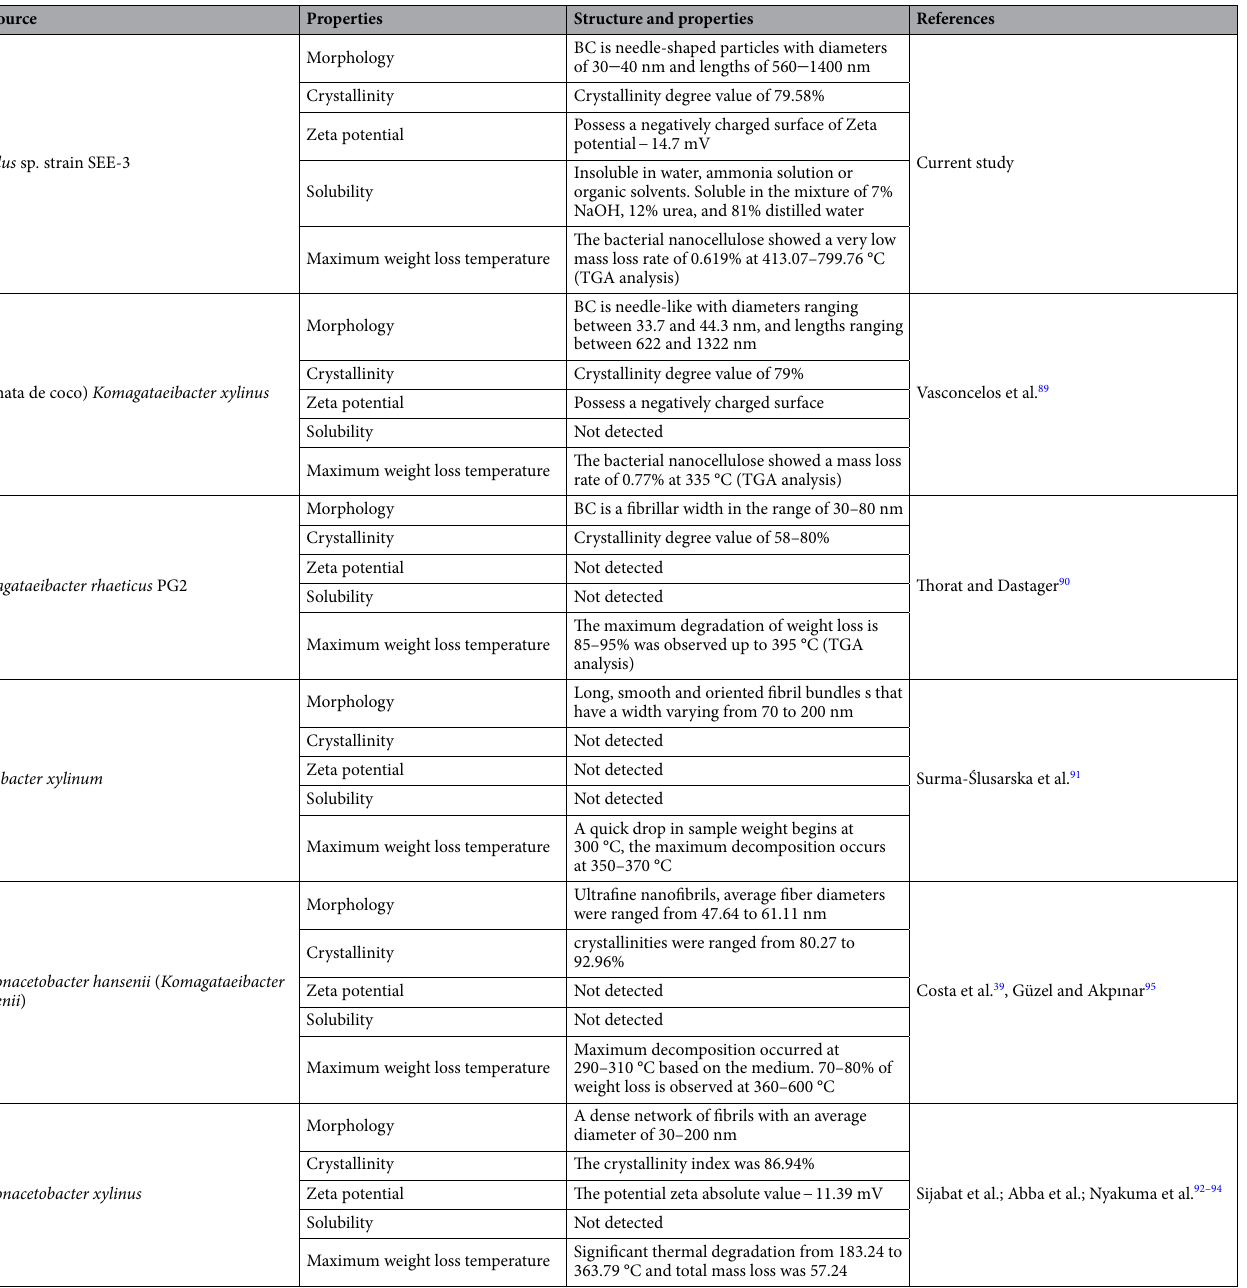
Table 1. Features of the bacterial cellulose produced by the strain SEE-3 in comparison with other bacterial